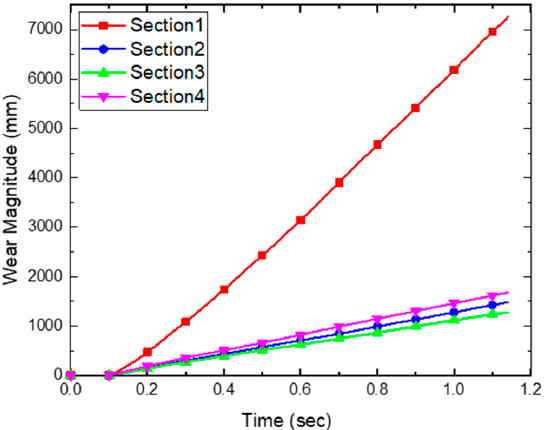
Figure 18. History of wear magnitude (total) in each section.